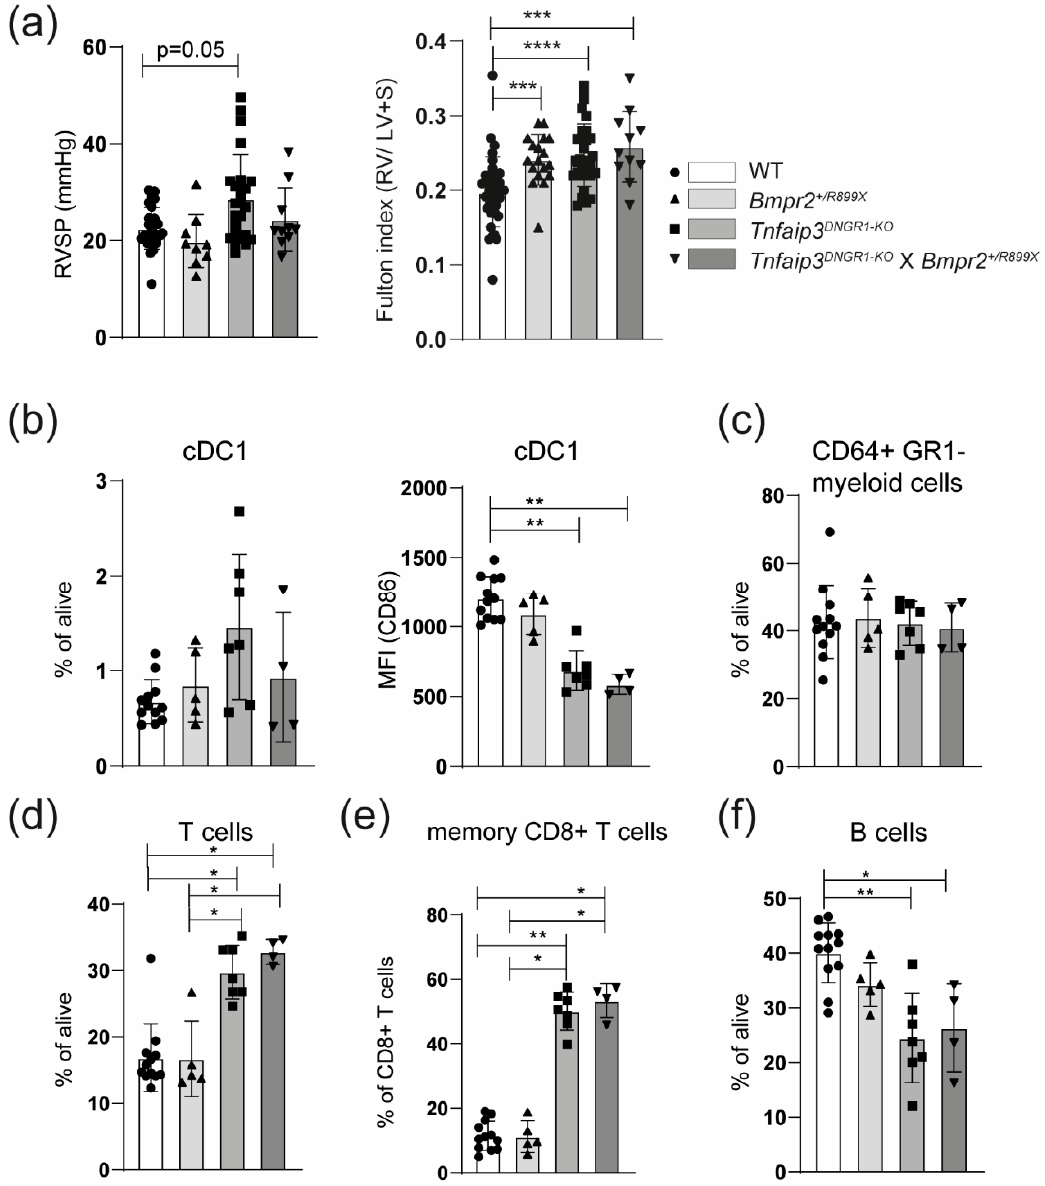
Figure 3. Concomitant Bmpr2 mutation does not alter the pulmonary hypertension (PH) phenotype in Tnfaip3 DNGR1 ‐ KO mice. ( a ) Right ventricular systolic pressure (RVSP), determined by right heart catheterization and hypertrophy of RV measured by Fulton index (right ventricle/ left ventricle + septum) of the indicated mouse groups; ( b ) quantification of lung CD103+CD11c+ cDC1 frequencies and CD86 expression (MFI = median fluorescence intensity) by flow cytometry; ( c – f ) quantification of CD64+GR1 ‐ monocyte/macrophage population ( c ), CD3+ T cells ( d ), memory CD44+CD62L ‐ CD8+ T cells ( e ) or CD19+ B cells ( f ) determined by flow cytometry in the lungs of the indicated mouse groups. Results are presented as mean + standard deviation of 10–31 mice ( a ) or 4–12 mice ( b – e ) per group. * p < 0.05, ** p < 0.01, *** p < 0.001, **** p < 0.0001.